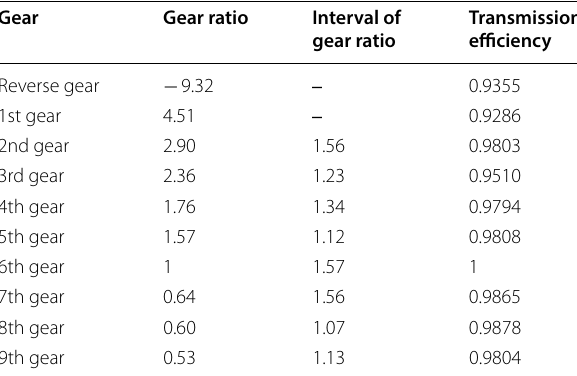
Table 8 Gear ratios, interval of gear ratio and